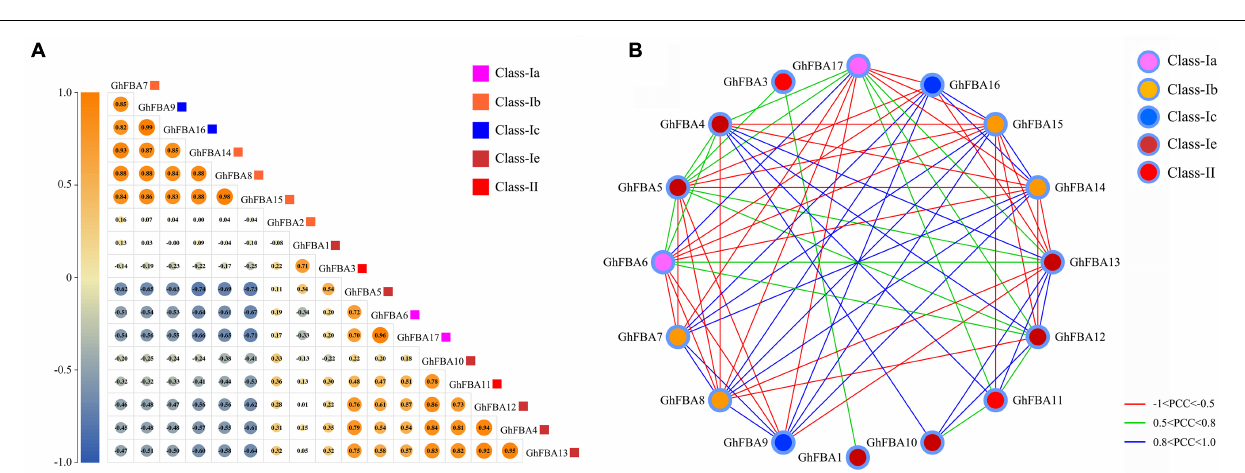
FIGURE 9 | Pairwise correlation and co-regulatory networks of GhFBA genes. (A) Correlation analysis of GhFBA genes. The correlations were based on the PCC values and represented by the size and color of the circles. The squares with different colors were used to represent different subclasses. (B) Co-regulatory networks of GhFBA gene pairs with | PCC| > 0.5 and p -value < 0.05. The edge lines with different colors represent the correlation levels of GhFBA gene pairs and the nodes with different colors indicate the information of different